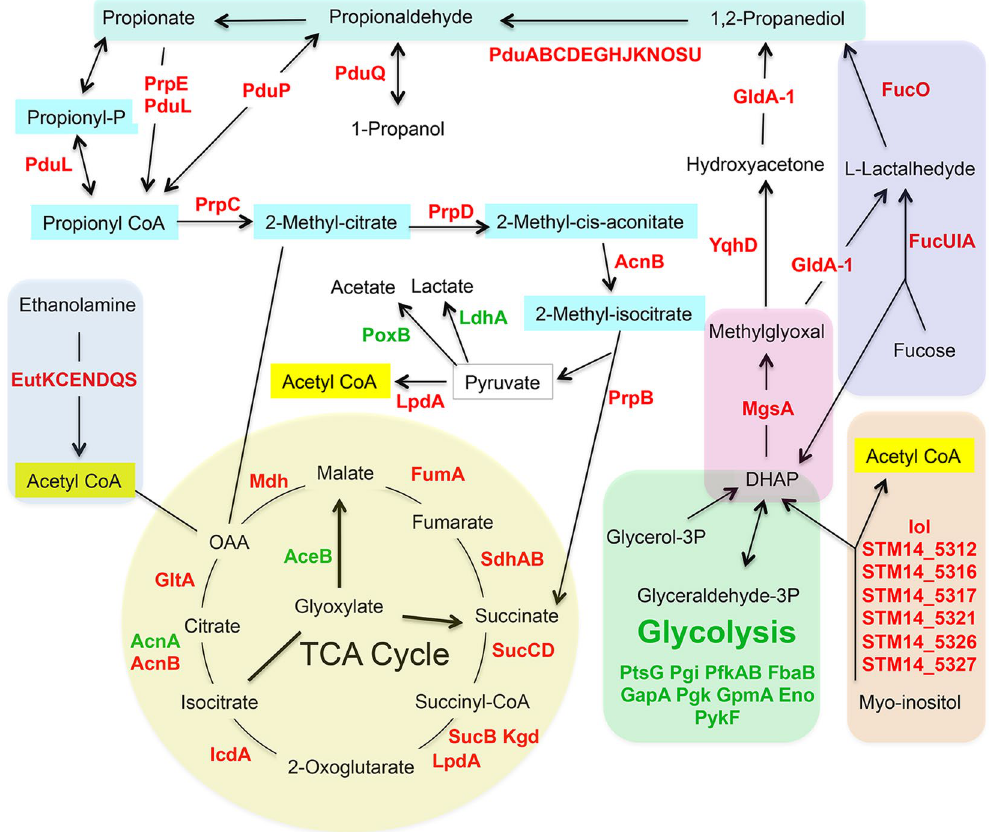
Figure 4. σ S control of metabolic pathways revealed by proteomic analyses. Metabolic pathways down- regulated by σ S are shown schematically, including the TCA cycle, propionate catabolism (Fig. 3) and myo-inositol, ethanolamine, propanediol and L-fucose degradation (Fig. 5). The ability of S . Typhimurium ATCC14028 to utilize myo-inositol is conferred by the iol genes (from STM14_ 5307/ iolR to STM14_5327/ iolH ) 47, 62 . The pduABCDEFGHJKLMNOPQSTUVWX and eutSPQTMNEJGHABCLKR gene clusters allow Salmonella to grow using propanediol and ethanolamine as sole carbon source, respectively 63–66 . Proteins involved in the indicated pathways and showing differential abundance in the wild type and Δ rpoS strains of Salmonella , with a p-value of less than 0.05, are indicated (Supplementary Dataset S3). Proteins in red and green were down- and up-regulated by σ S , respectively. DHAP: Dihydroacetone